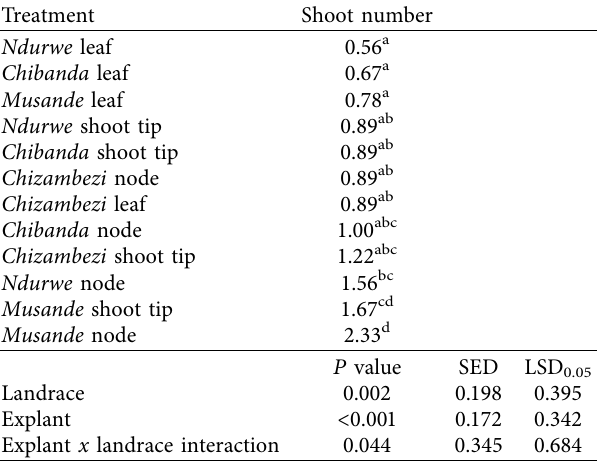
Table 2: Effect of landrace and explant on the average shoot